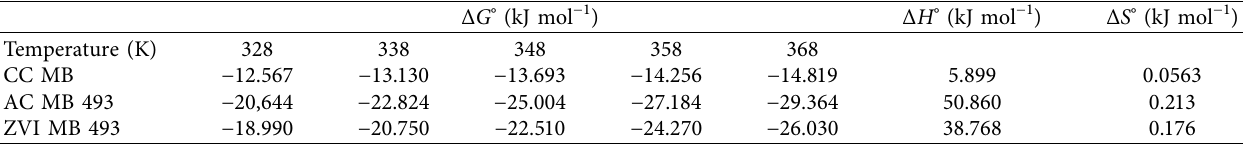
Table 6: Equilibrium constants, standard Gibbs free energy, enthalpy, and entropy of carotenes adsorption from crude palm oil onto CC MB, AC MB 493, and ZVI MB 493 at 95 °